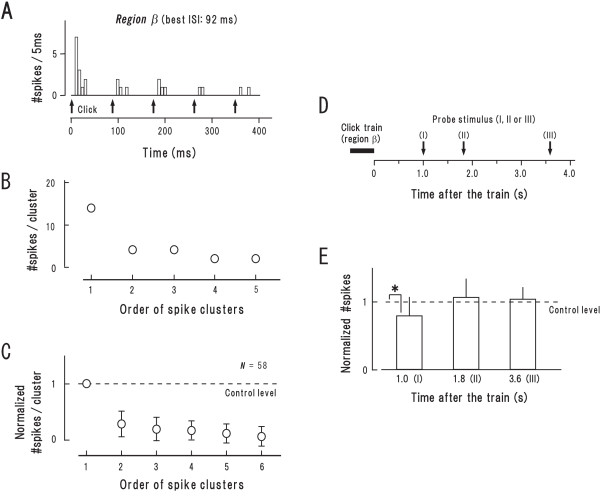
Accumulation effect of responses in region β (at the best ISI) (A-C) and its durability (D, E). A, B: Peri-stimulus time histogram (bin width = 5 ms) (A) and sequential plot of the number of spikes (# spikes) involved in each discharge cluster (every discharge cluster was elicited by single clicks) (B). C: Population data (mean ± SD) in the same format as B except that #spikes was normalized to that involved in the 1st discharge cluster (= control level; same as followings). D: The procedure for measuring the responsivity after the trains that were delivered at the best ISI: a single click (= probe stimulus; arrows) was presented at either 1.0 s (I), 1.8 s (II) or 3.6 s (III) after the termination of the train. E: Population data of the normalized #spikes measured according to D. *P < 0.05 (paired t-test). Note (1) responsivity gradually declined with the progression of the train (C), and (2) the response degeneration lasted for 1.0-1.8 s after the termination of the train (E).